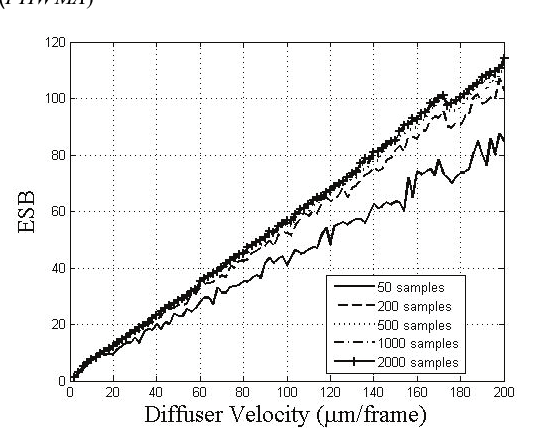
Fig.5 Energy of spectral bands